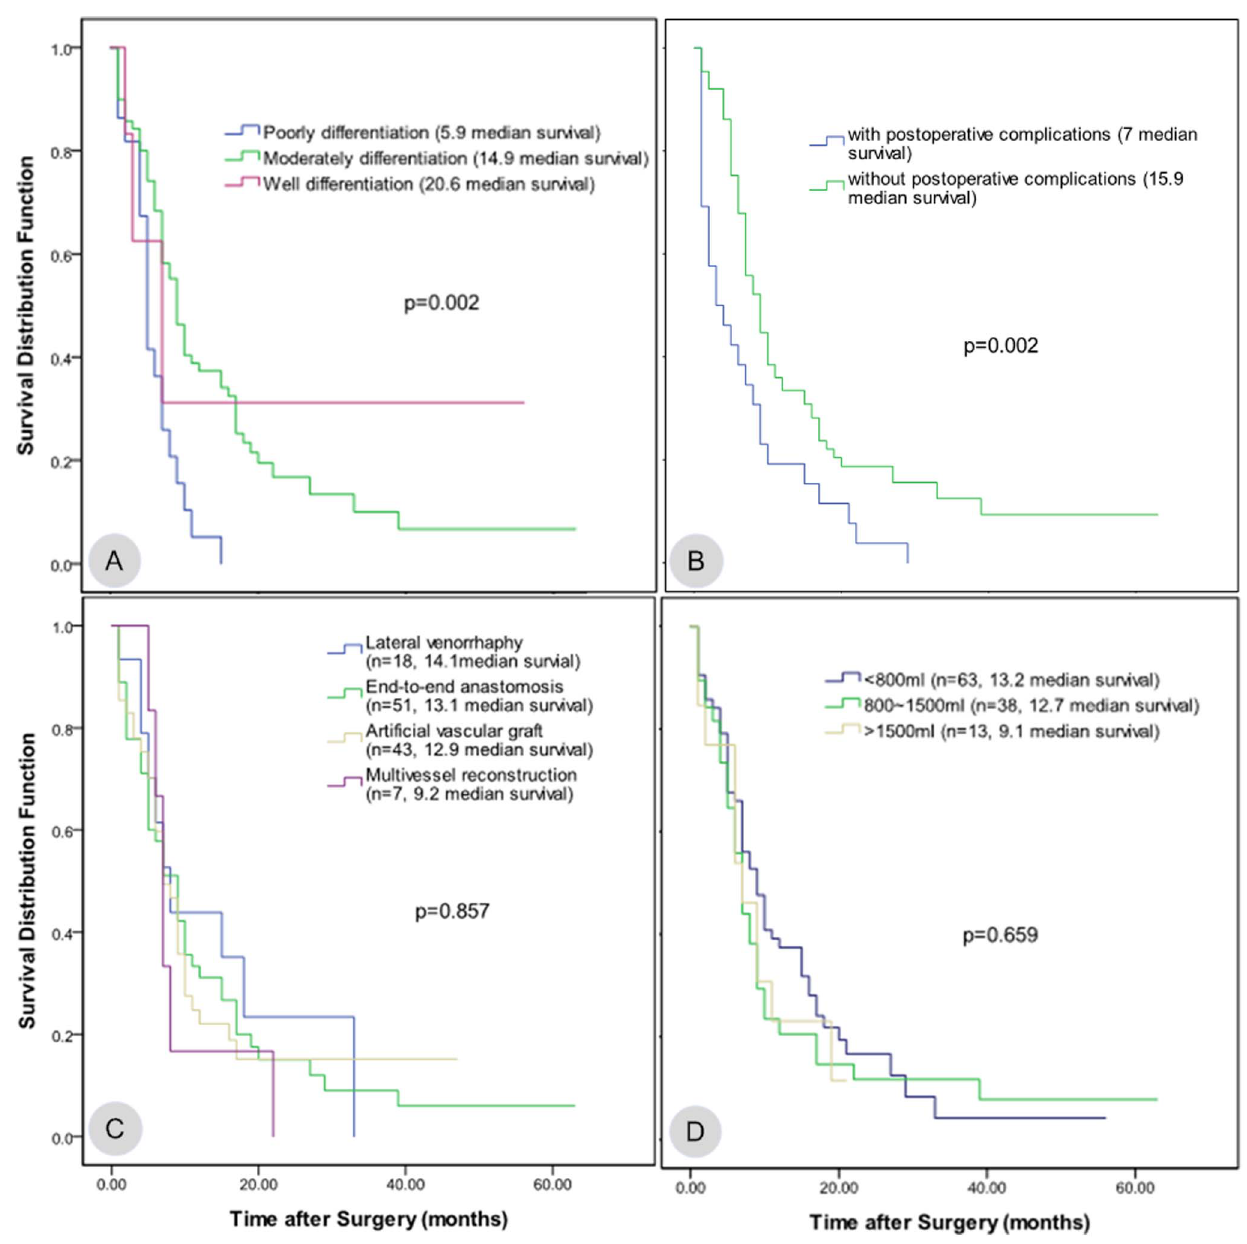
Figure 3. The relationship between the parameters of patients treated with combined vascular resection and reconstruction and postoperative survival time. A. The patients were divided into three groups based on the degree of differentiation. The median survival times and 95% confidence intervals for each group were 5.9 (4.3, 7.4), 14.9 (10.7, 19.2), and 20.6 (0, 45.1), respectively, with p=0.002. B. The patients were divided into two groups with or without postoperative complications. The median survival times and 95% confidence intervals were 7 (4.0, 10.0) and 15.9 (11.6, 20.1), respectively, with p=0.002. C. The patients were divided into four groups according to the different methods of vascular reconstruction. The median survival time and 95% confidence intervals for each group were 14.1 (7.1, 21.1), 13.1 (8.5, 17.8), 12.9 (8.0, 17.8), and 9.2 (4.0, 14.3), respectively, with p=0.857. D. The patients were divided into three groups according to the volume of intraoperative blood loss: less than 800 ml, 800 to 1500 ml, and more than 1500 ml. The median survival times and 95% confidence intervals for each group were 13.2 (9.7, 16.8), 12.7 (7.1, 18.3), and 9.1 (5.4, 12.7), respectively, with p=0.659. doi:10.1371/journal.pone.0070340.g003 (PV,SMV,spleen vein), 15 cases with arterial resection (SMA, is not a contraindication of PD combined with vascular resection. CHA, splenic artery), and 1 with right kidney resection. After Most physicians are cautious about the performance of PD comparison, we found that there was no significant difference combined with arterial resection and reconstruction, mainly because they suppose the patients with arterial invasion might between the complication rates of PD combined with arterial and venous resection, while the mortality rates of the former is have undergone tumor distant metastasis while venous invasion is remarkably higher than the latter one. However, arterial invasion a function of tumor size. But this viewpoint needs the support of